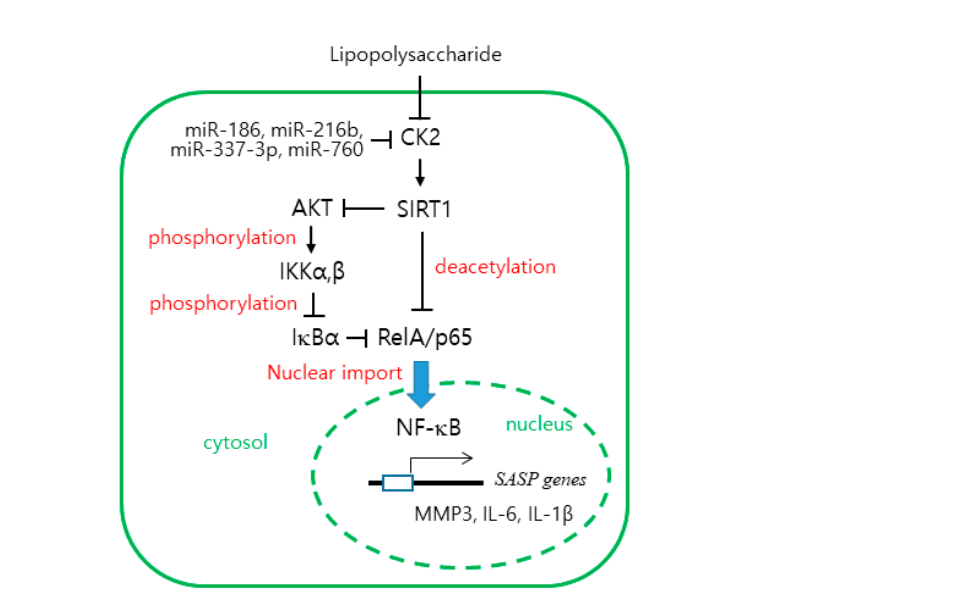
Figure 6. The working model for the CK2 down-regulation-mediated expression of SASP factors. CK2 down-regulation induces SIRT1 inhibition and AKT up-regulation, which elevate the nuclear import of RelA/p65 by increasing RelA/p65 acetylation and I κ B destabilization, respectively. Subsequently, active NF- κ B stimulates the transcription of SASP genes, including MMP2, IL-6, and IL-1 β . LPS down-regulates CK2. The antisense inhibitors of miR-186, miR-216b, miR-337-3p, and miR-760 exhibit anti-inflammatory